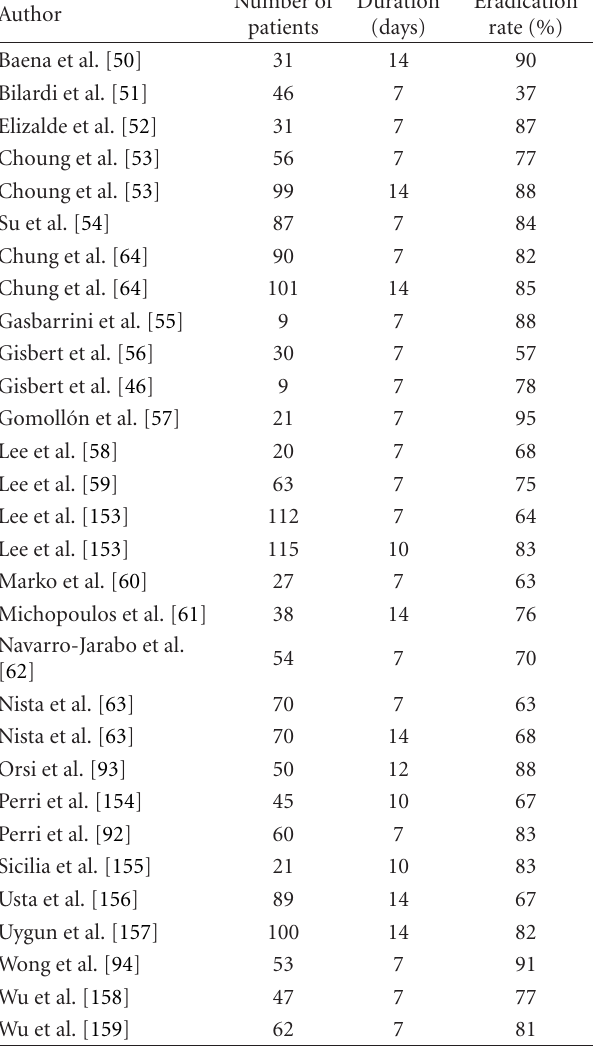
Table 1: Eradication rates with quadruple therapy (proton pump inhibitor, bismuth, tetracycline, and a nitroimidazole) as “rescue” therapy for proton pump inhibitor-clarithromycin-amoxicillin fail-